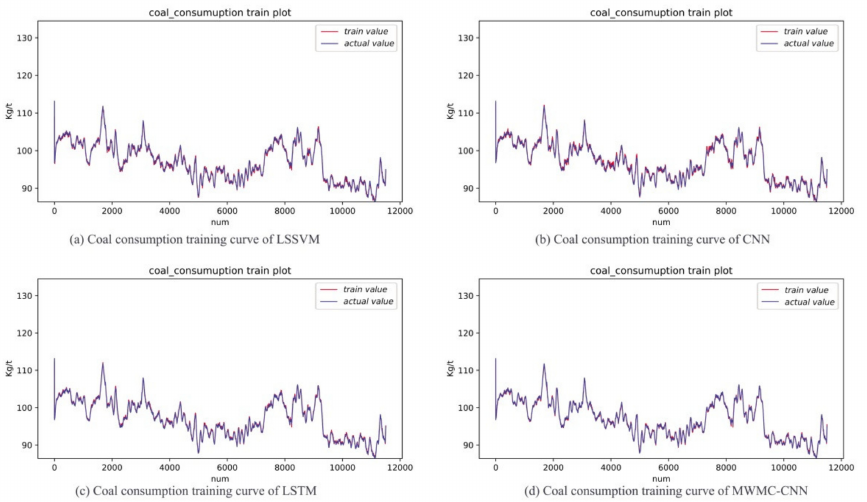
Figure 7. Coal consumption training result curves of LSSVM, CNN, LSTM and MWMC-CNN.